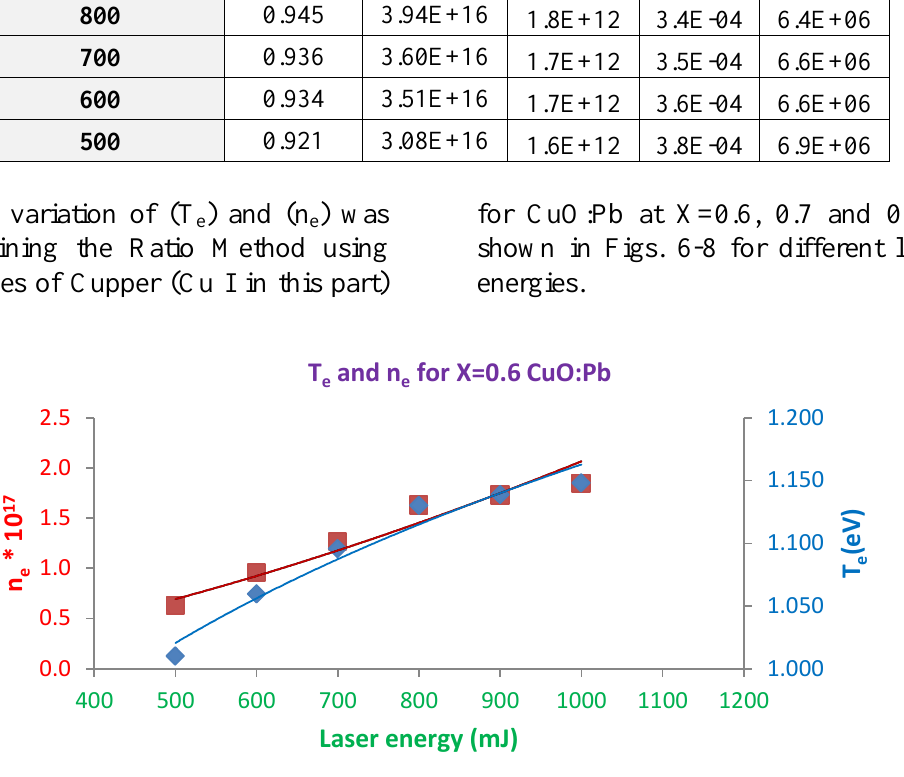
) and (n ) versus the laser energy for CuO:Pb at X=0.6 in e e